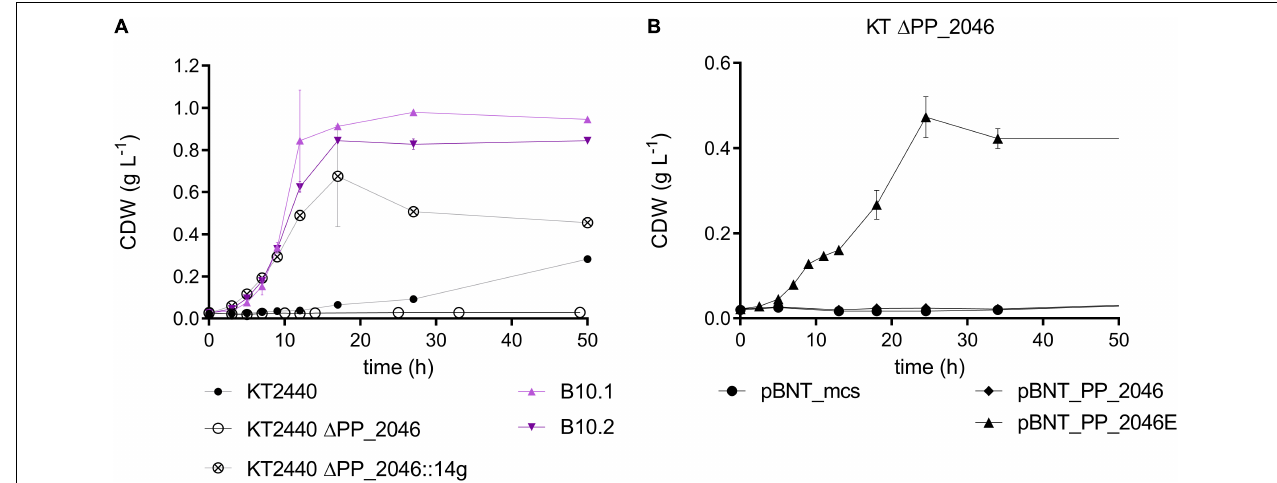
FIGURE 5 | (A) Biomass growth during the cultivation of P. putida KT2440 (black, circles), B10.1, B10.2 (purple, triangles), P. putida KT2440 (cid:49) PP_2046 (black, circle) and P. putida KT2440 (cid:49) PP_2046:14g (black, circled cross) in MSM medium with 20 mM 1,4-butanediol. (B) Biomass growth of P. putida KT2440 (cid:49) PP_2046 transformants harboring an overexpressing construct for PP_2046 or PP_2046E and the empty vector cultivated in MSM with 20 mM 1,4-butanediol. Error bars indicate the deviation of the mean ( n =